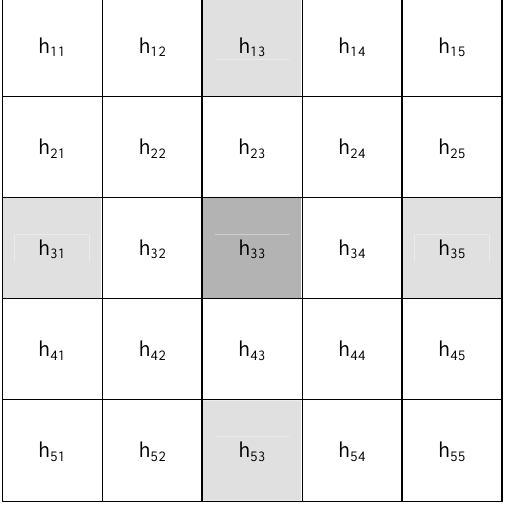
Fig 7. Height differences calculation using neighborhood cells in grid model Sud ė tingo reljefo vietov ė se gali b ū ti sunku realizuoti